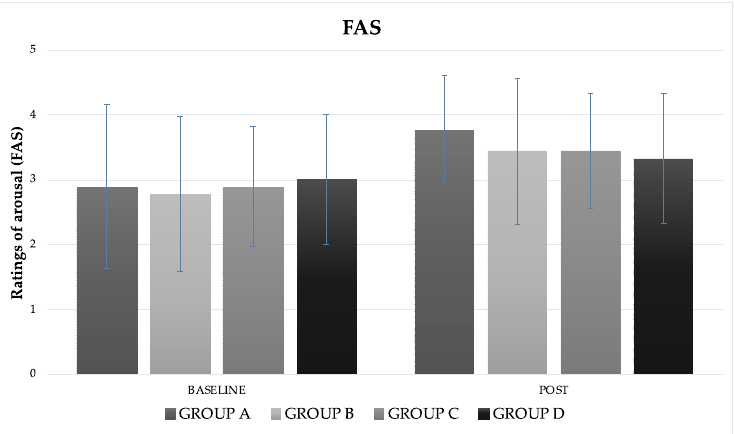
Figure 2. Mean ± SD of pleasure–displeasure ratings (Feeling Scale, FS) measured before and after the intervention.